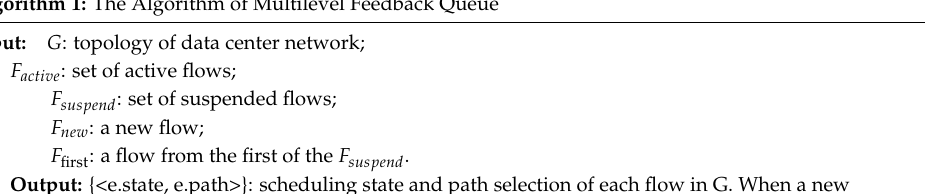
Algorithm 1: The Algorithm of Multilevel Feedback